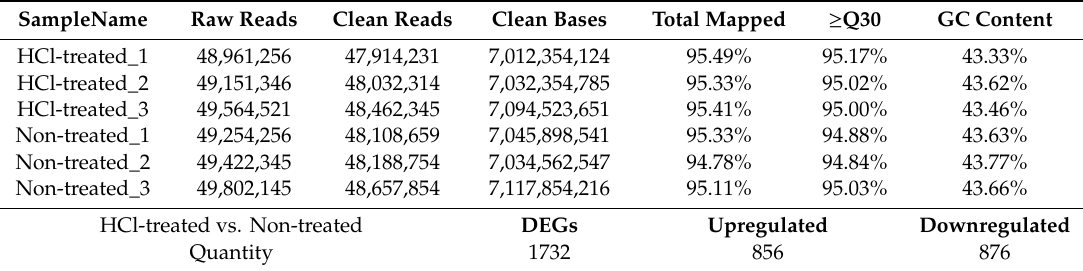
Table 1. Statistical analysis of RNA-seq data obtained of diapause-destined eggs (non-treated) and diapause-terminated eggs